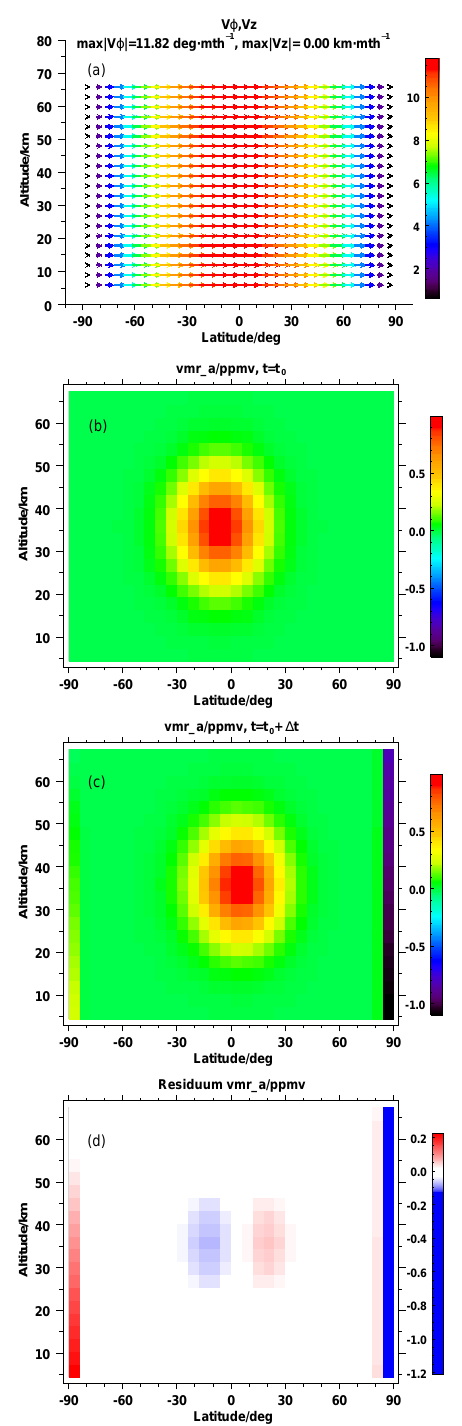
Figure 2. Test case: (a) velocity field; (b) initial distribution of gas (a); (c) distribution of gas (a) after 1 month; (d) residual be- tween distribution of gas (a) after 1 month predicted with the result- ing and the correct velocities. The units of the color bar in (a) are degrees per